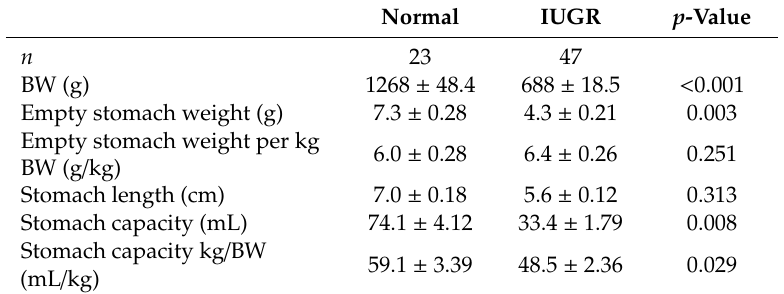
Table 1. A comparison between normal and intrauterine-growth-restricted (IUGR) piglets for di ff erent measurements of the stomach and bodyweight (BW). Values are presented as means ±